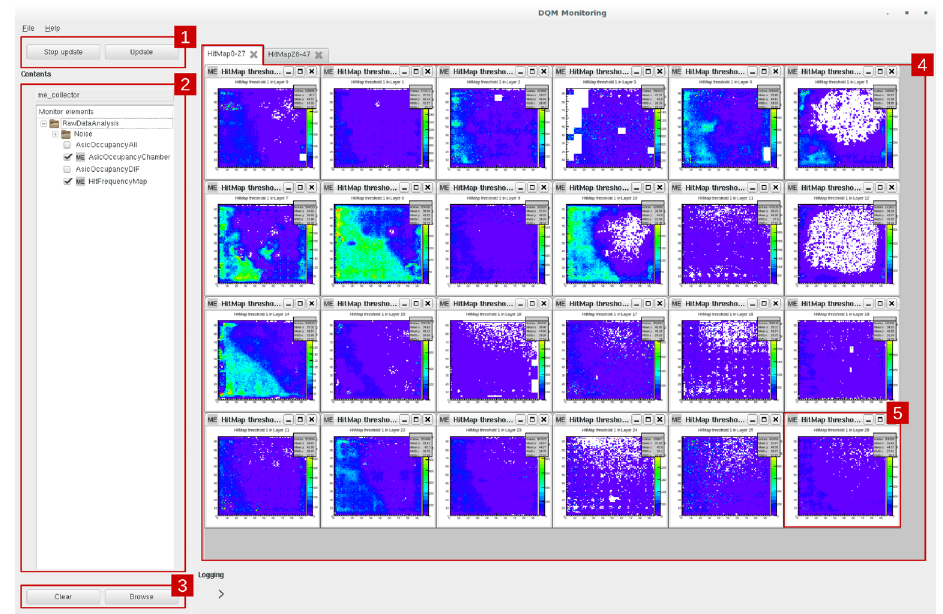
Figure 3. Main window of the monitoring GUI. 1: Option for manual / auto update of the visualization. 2: Selected Monitor Elements ( ME ) organized in a tree-like structure 3: Open a Browse window to create the ME selection available in 2. 4: Drawing section for MEs , it can be organized in multiple tabs. 5: Drawn ME are valid ROOT object that can be manipulated (zoom, scale change, fit,